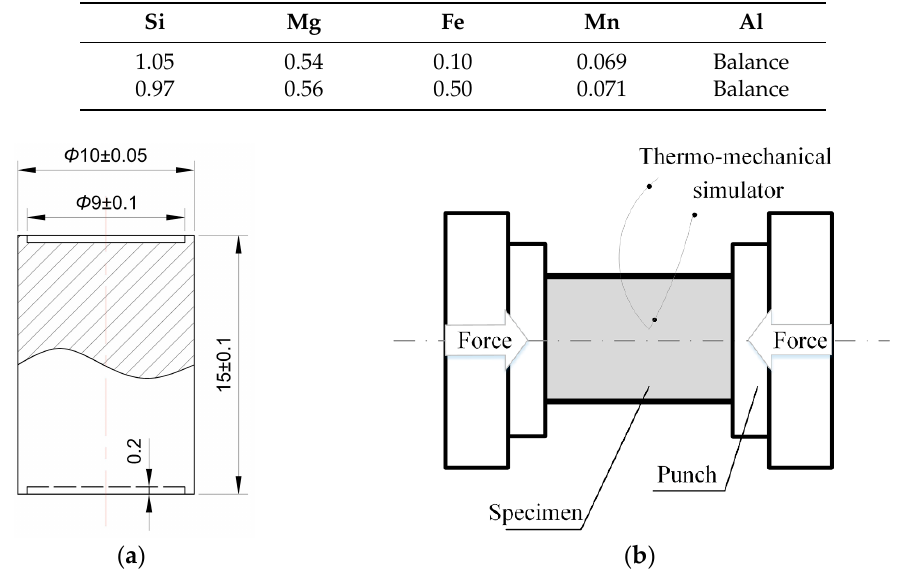
Table 1. The chemical composition of the recycled Al alloys with different contents of Fe (unit in wt %).